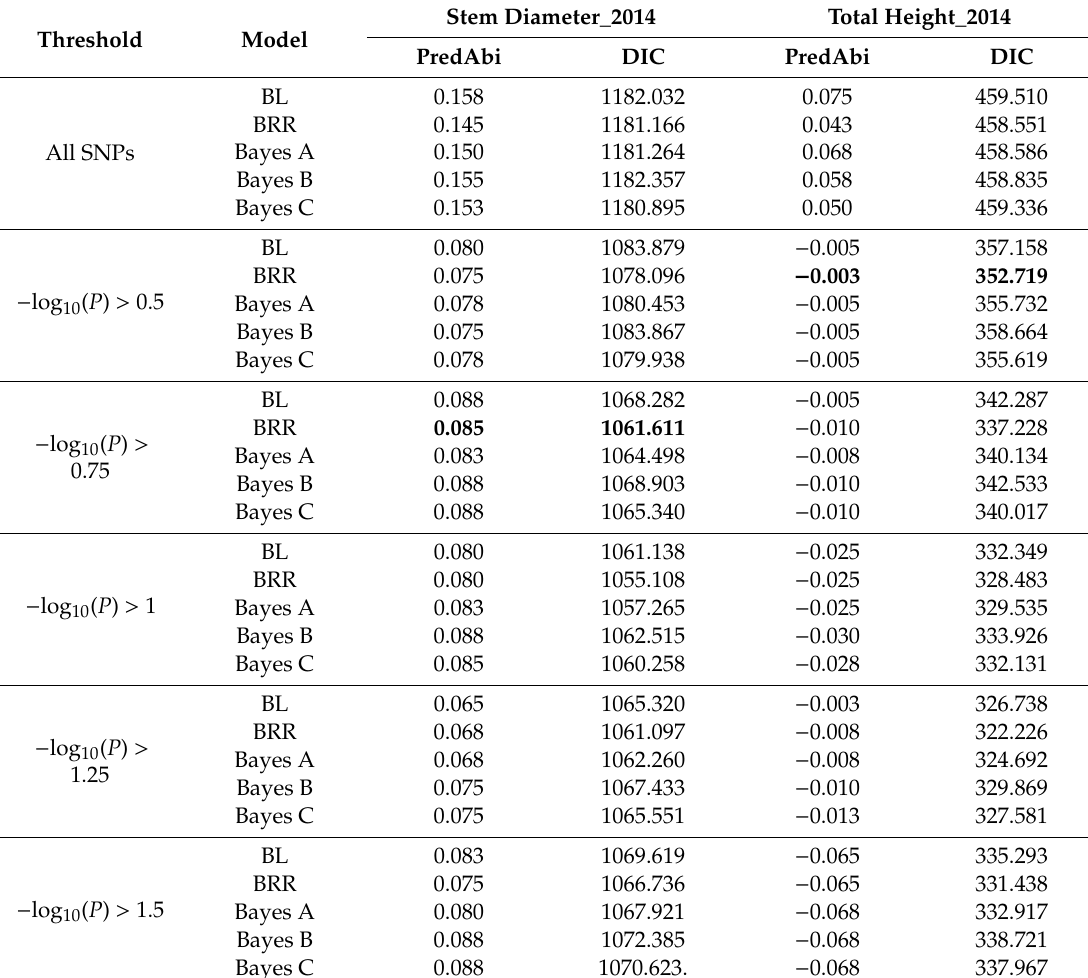
Table 2. Mean predictive ability and Deviance Information Criterion of growth traits of the S. platyclados population, before thinning, derived using all SNPs and sets meeting GWAS-based criteria obtained with indicated Bayesian models (Bayesian LASSO, Bayesian Ridge Regression, Bayes A, Bayes B and Bayes